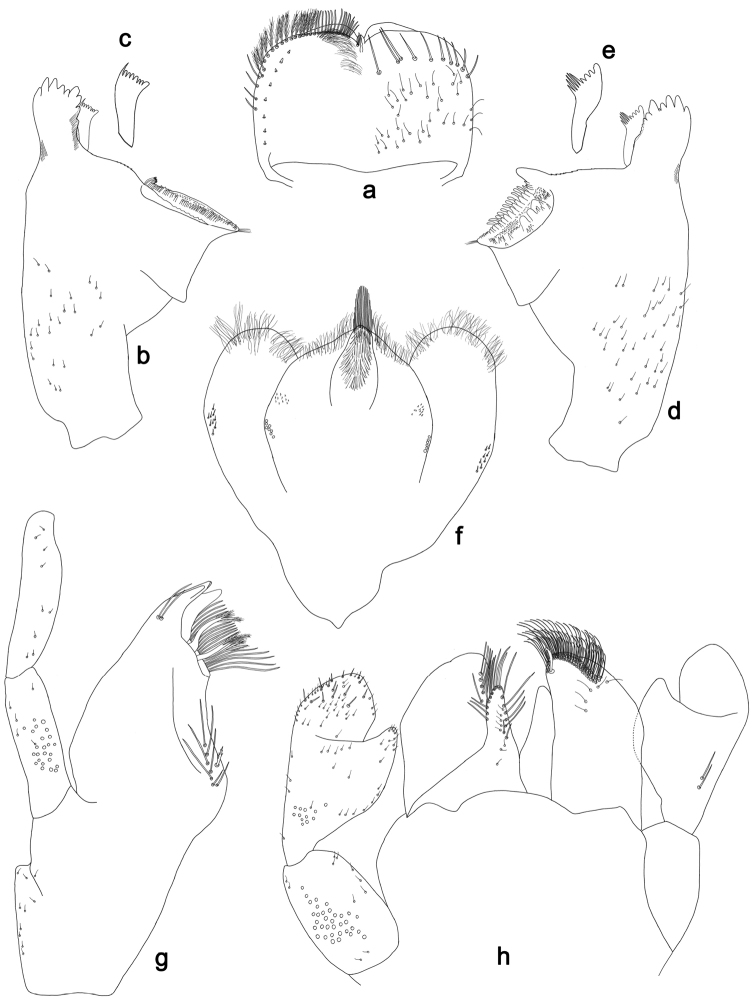
Labiobaetisparavultuosus sp. n., larva morphology: a Labrum b Right mandible c Right prostheca d Left mandible e Left prostheca fHypopharynxg Maxilla h Labium.